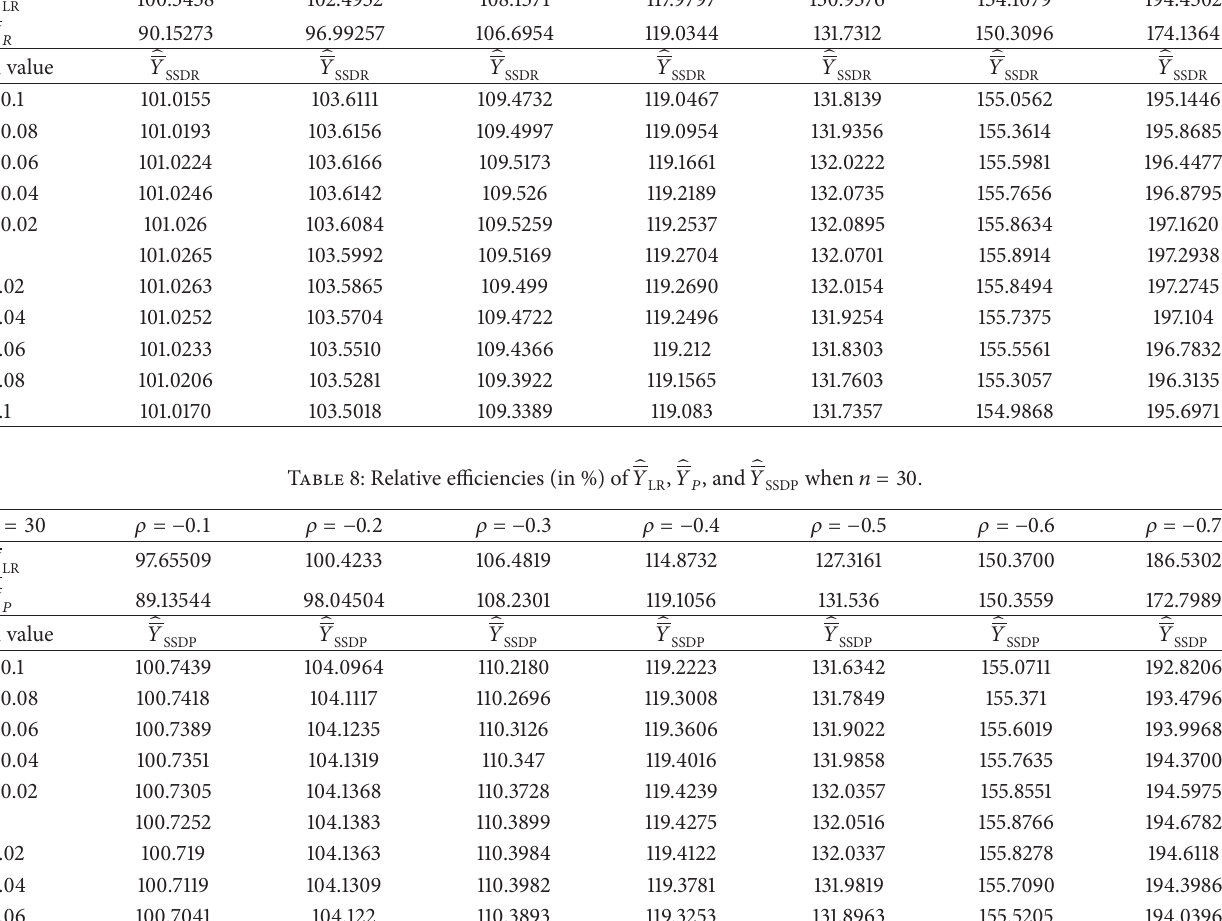
̂ 𝑌 when 𝑛 = 100 . SSDR